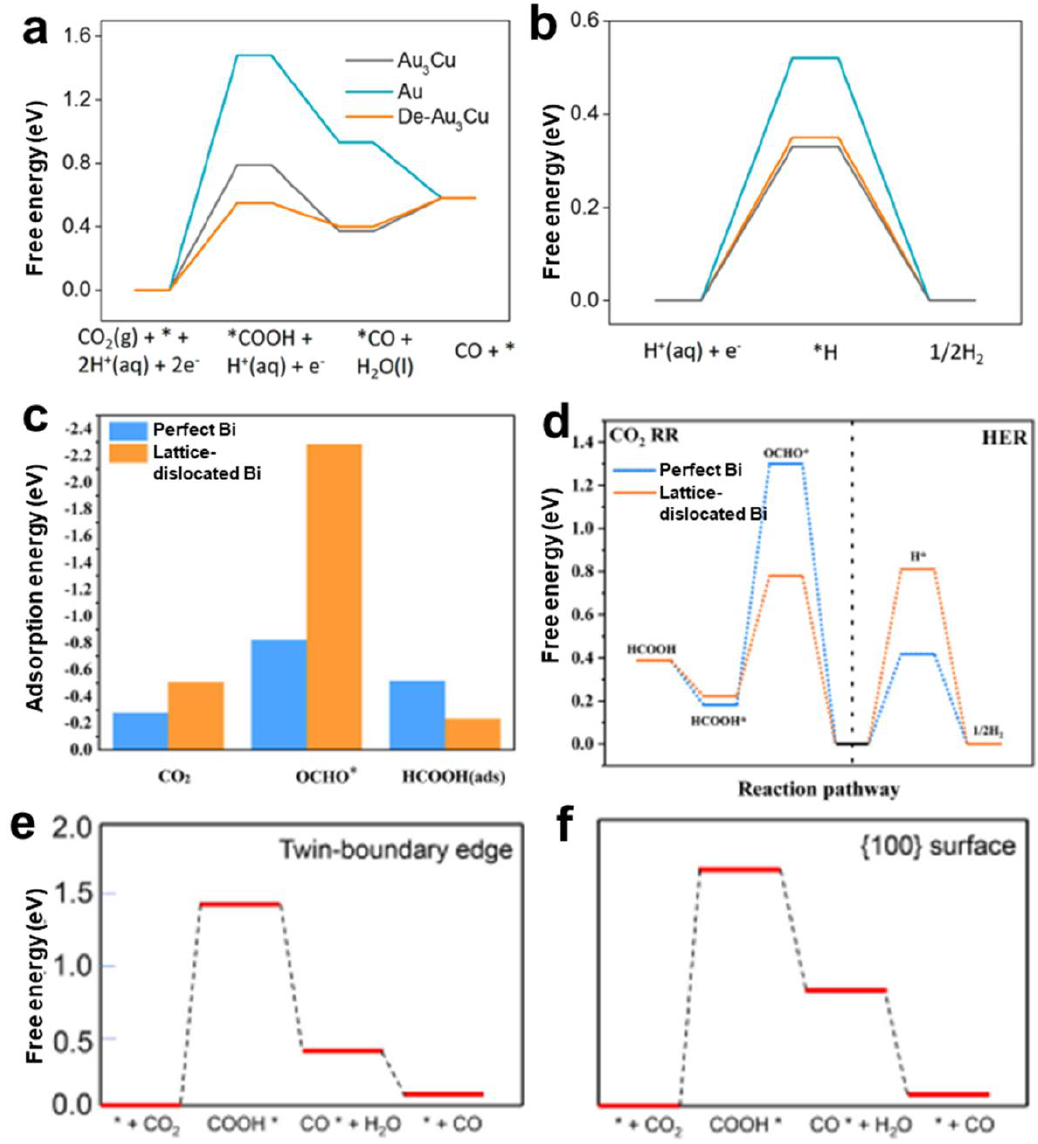
Figure 7. Relationship between defects and CO 2 RR. Free energy of Au, Au 3 Cu and dealloyed Au 3 Cu (De–Au 3 Cu) for the generation of ( a ) CO and ( b ) H 2 . Reproduced with permission [31]. Copy- right 2018, American Chemical Society. ( c ) Adsorption energy of CO 2 , OCHO* and HCOOH (ads). ( d ) Free energies plots of HCOOH and H 2 formation for perfect and lattice–dislocated Bi nanosheets. Reproduced with permission [64]. Copyright 2022, Elsevier. Free energy plots for CO 2 RR at the ( e ) twin − boundary edge and ( f ) on the Ag {100} surface. Reproduced with permission [68]. Copyright 2020,